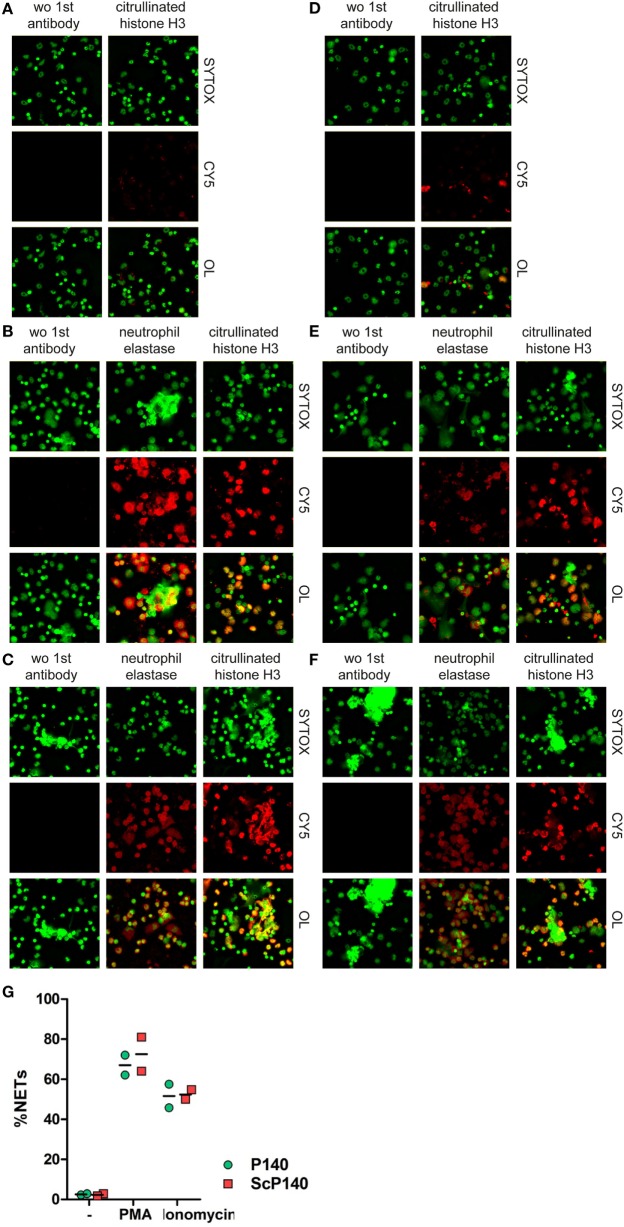
Morphological analysis and quantification of neutrophil extracellular traps (NETs) in P140 and scrambled P140 (ScP140)-treated mice by fluorescence microscopy. Representative immunofluorescence images of SYTOX Green-, neutrophil elastase (NE)-, and citrullinated histone H3 (citH3)-stained neutrophils isolated from ScP140- (A–C) and P140- (D–F) treated mice and incubated without external stimulus (A,D), with PMA (B,E) or with ionomycin (C,F). Left panels show staining controls incubated without (wo) primary antibody to NE or citH3. CY5 stands for control Cyanin 5 and OL stands for overlay. (G) Quantitative analysis of NETs. Scatter plots show individual values and mean of %NETs (defined as % PI+/NE+ cells with >3-fold mean nuclear size) from two mice.